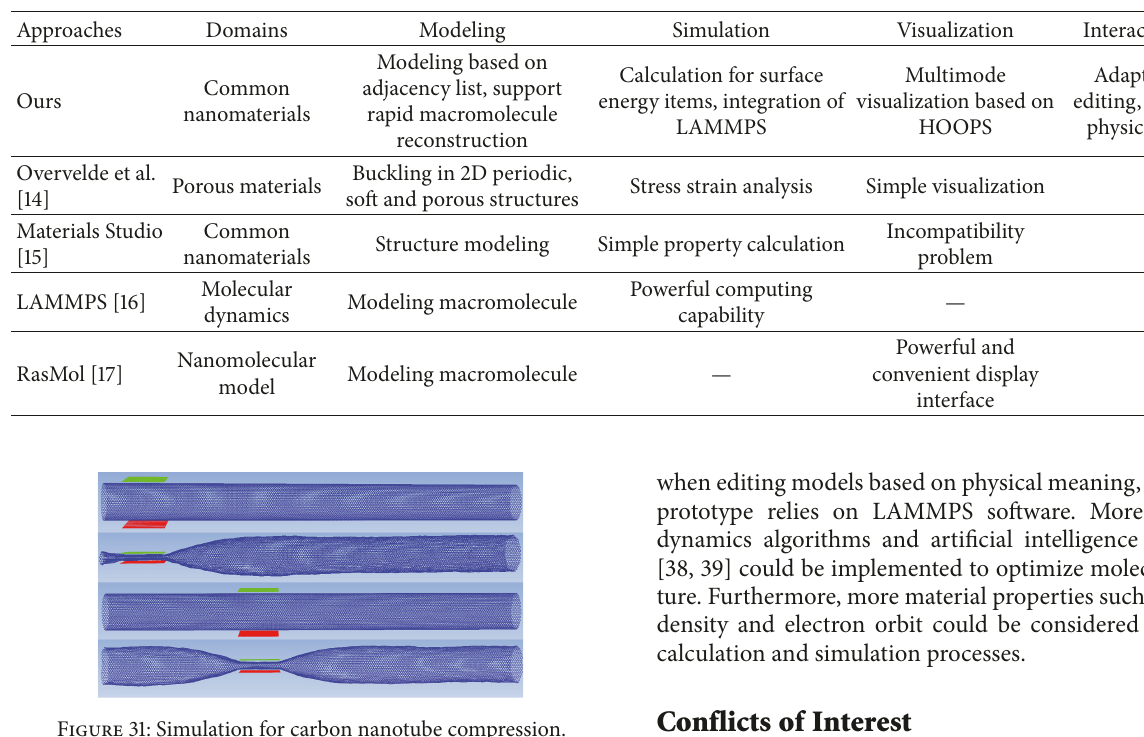
Table 1: Comparison with the existing systems.